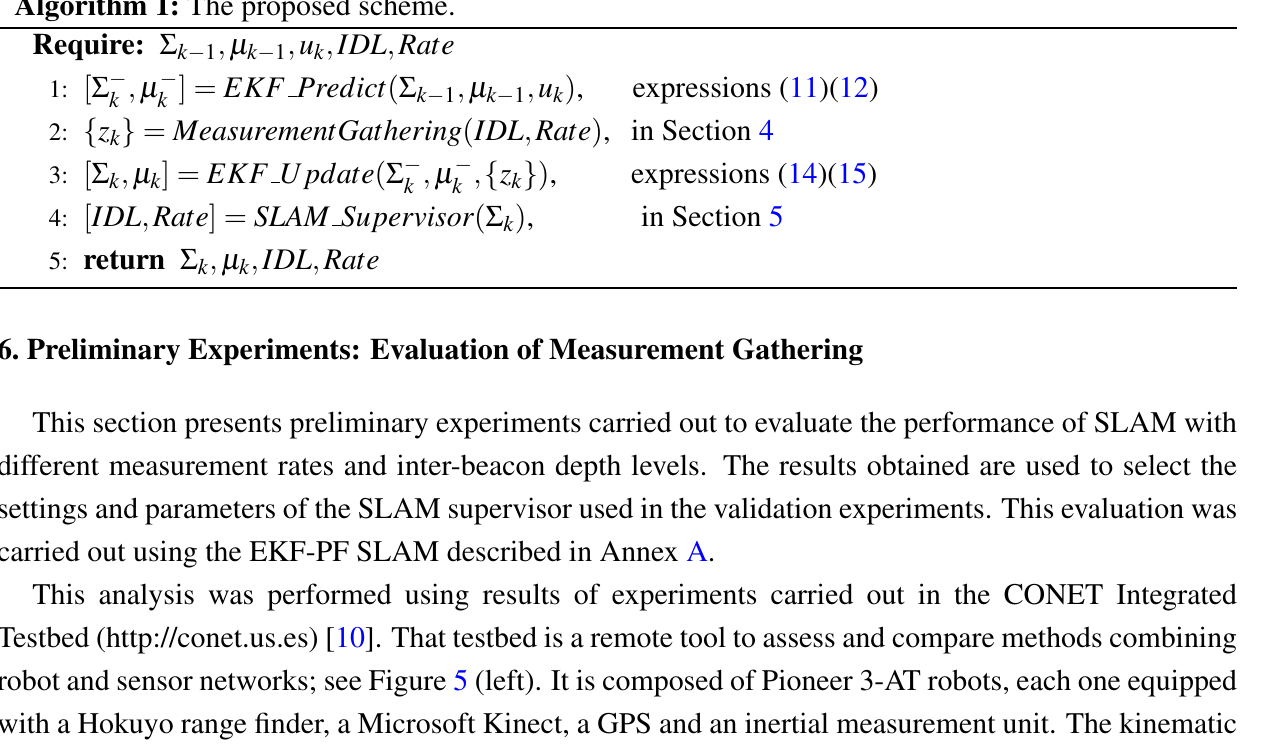
Algorithm 1: The proposed